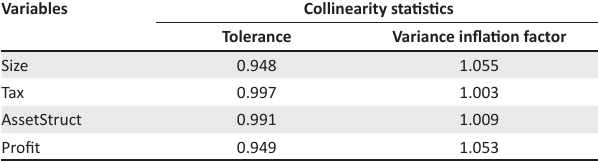
TABLE 8: Variance inflation